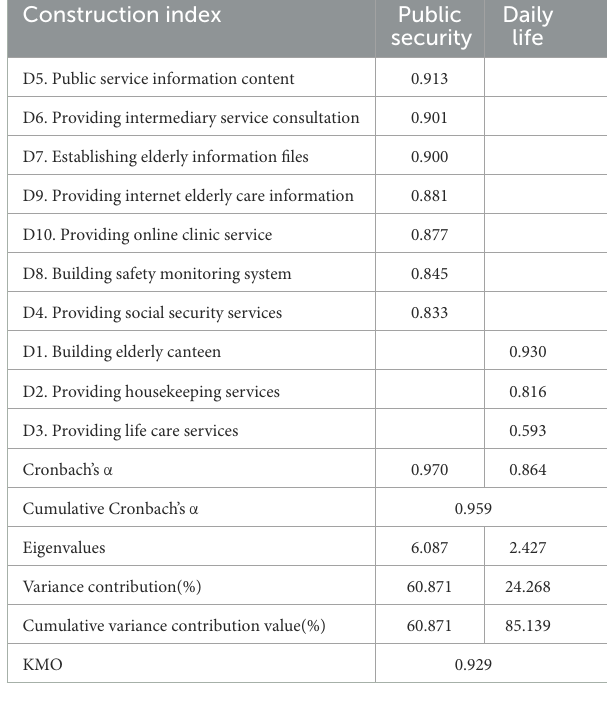
TABLE 4 Factor analysis result of “health care” dimension.